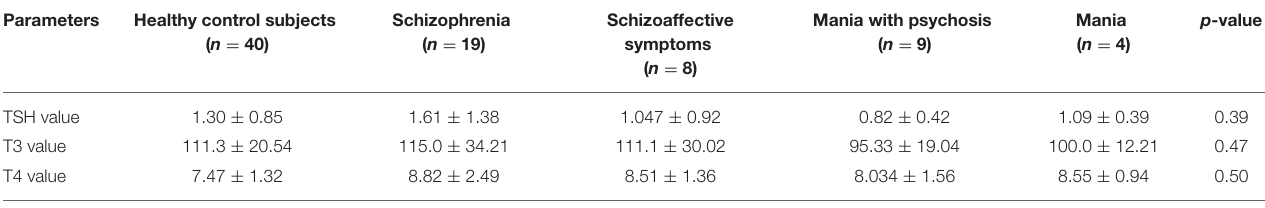
TABLE 3 | Biochemical evaluation of healthy control subjects vs. test group, i.e., patients with cannabis use and psychotic symptoms (schizophrenia, schizoaffective symptoms, mania with psychosis, and mania). Parameters